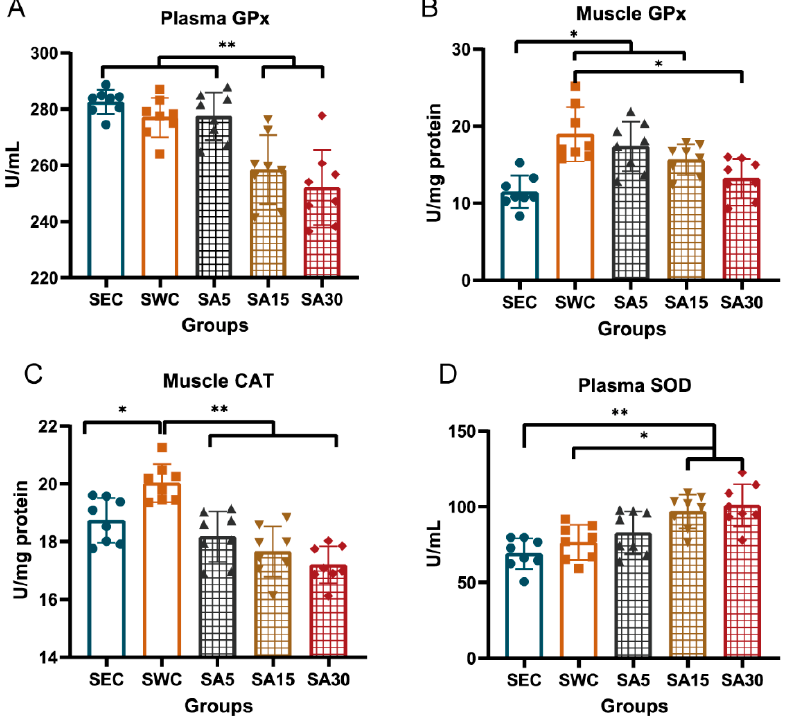
Figure 2. E ff ects of astaxanthin on the GPx, CAT, and SOD activity in swimming training mice. ( A ) and ( B ) display GPx activity in plasma and gastrocnemius muscle among di ff erent groups, respectively. ( C ) exhibits CAT activity in gastrocnemius muscle among various groups, respectively. ( D ) shows SOD activity in plasma among di ff erent groups Values are means ± SD ( n = 8). The symbol * indicates a significant di ff erence at p < 0.05, and ** indicates a significant di ff erence at p < 0.01.